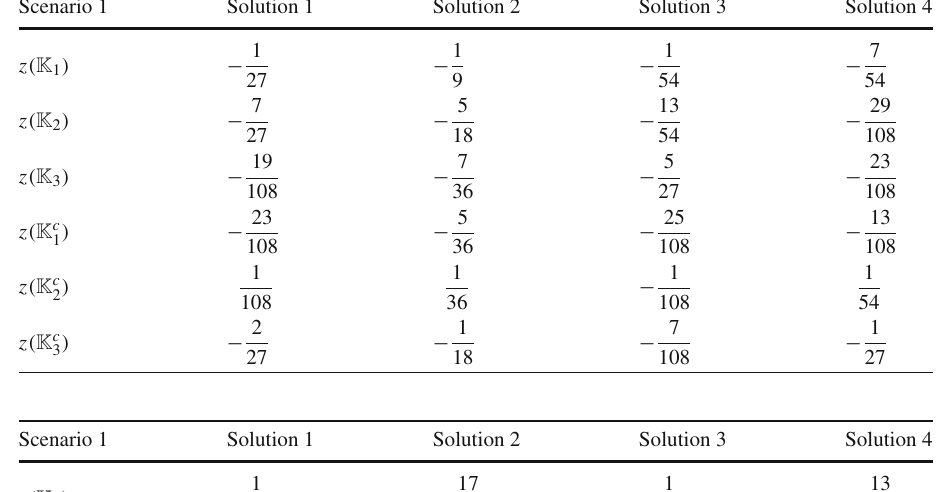
Table 6 The same as in Table 5, but with the minimal number of singlets under the SM gauge group n ν c = 3 and n ξ = 2